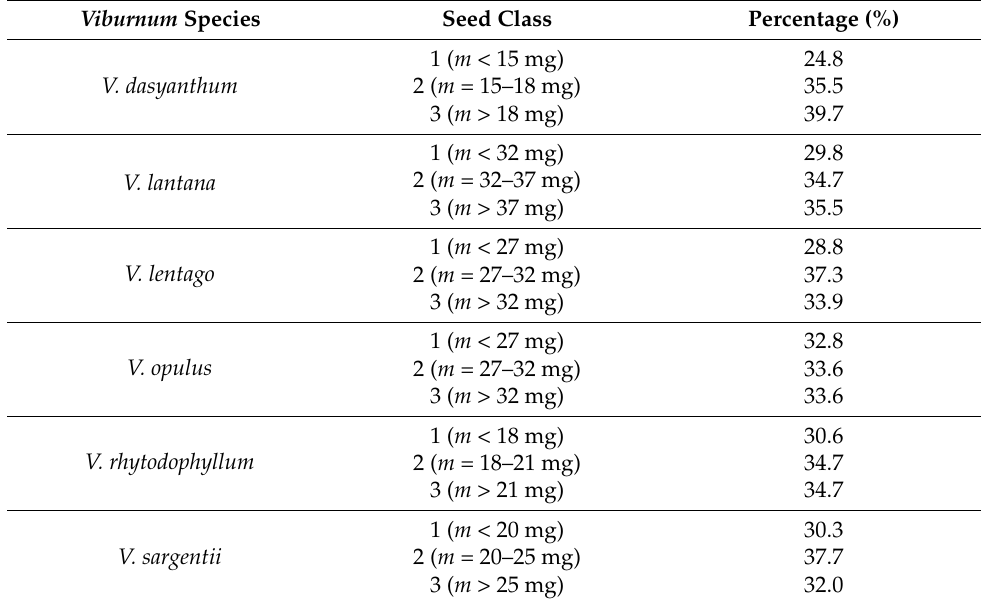
Table 4. Seed mass classes in the analyzed Viburnum